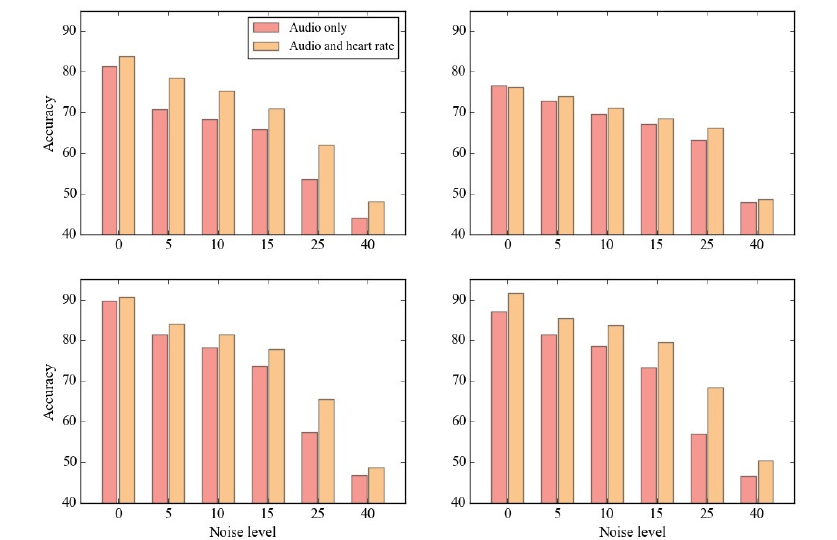
Figure 9. Performances of stress detection using the four detection methods: ( upper left ) DT , ( upper right ) NB , ( lower left ) SVM-R , and ( lower right ) SVM-L, according to the noise level (5, 10, 15, 25, 40) and utilized data (audio only and both audio and heart